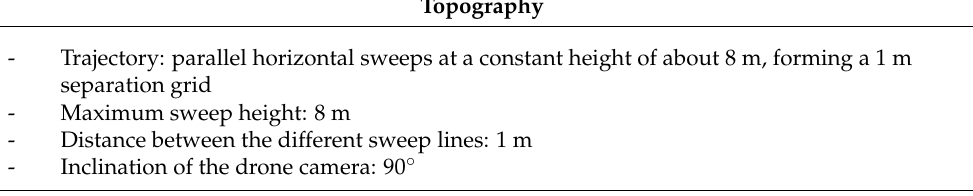
Table 1. Drone data collection